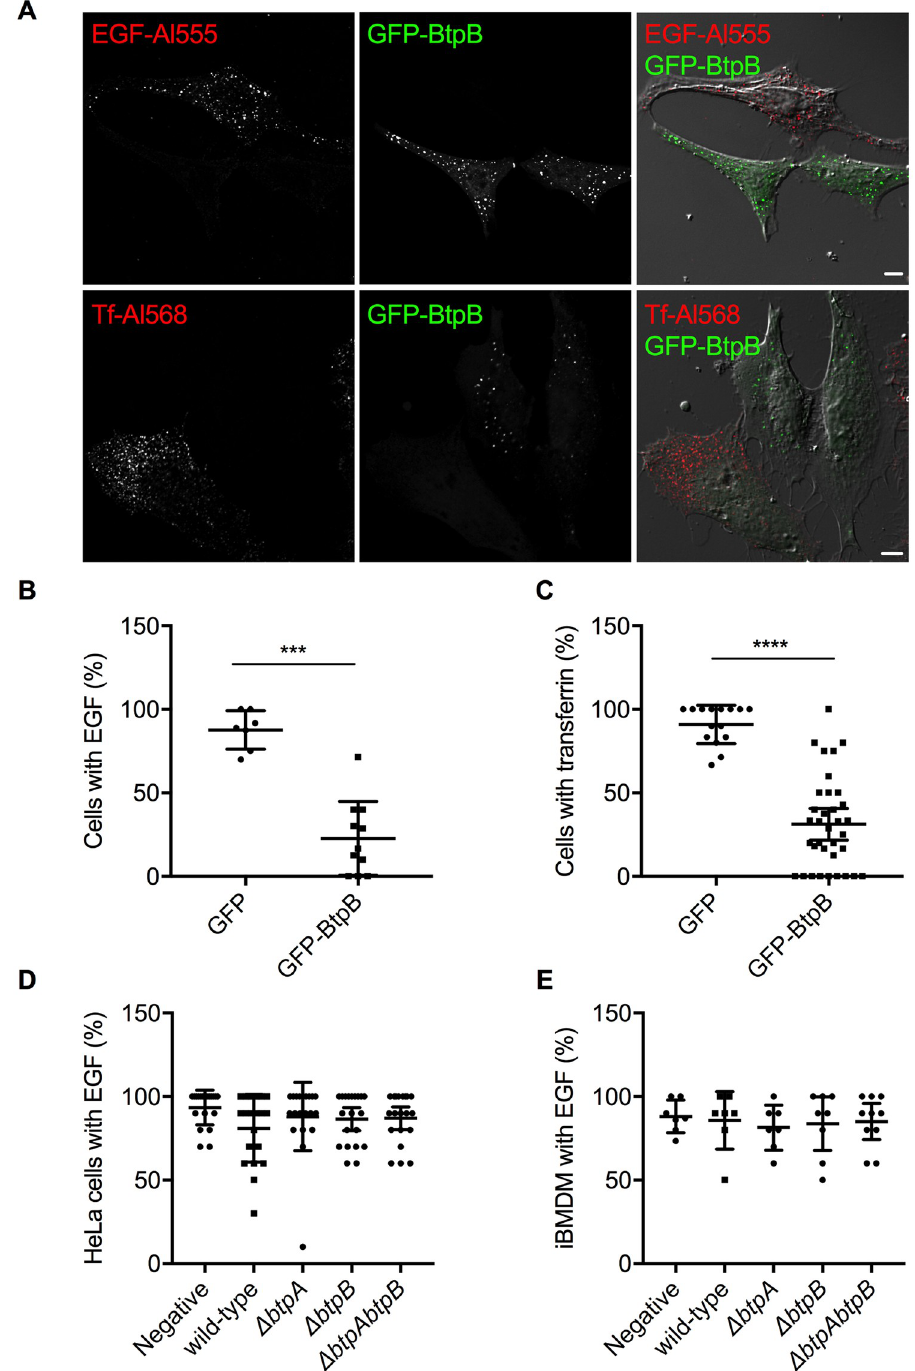
Fig 7. Inhibition of endocytosis occurs upon ectopic expression of BtpB but not during infection. HeLa cells expressing GFP-BtpB (green) were incubated with either EGF conjugated with Alexa Fluor 555 (red) or transferrin conjugated with Alexa Fluor 568 (red) for 10 minutes. (A) Cells were then analyzed by confocal microscopy and (B) and (C) the percentage of cells showing uptake of either fluorescent marker quantified. A cell was considered positive when clear labelling of endocytic vesicles was observed throughout the cell. Counts correspond to individual microscopy fields, obtained from three independent experiments. Data correspond to means ± standard deviation and statistical comparison was done with Mann-Whitney test, p = 0.0001 ( ��� ) for EGF (left) and p < 0.0001 ( ���� ) for transferrin (right). (D) HeLa cells or (E) immortalized bone marrow-derived macrophages (iBMDM) were infected for